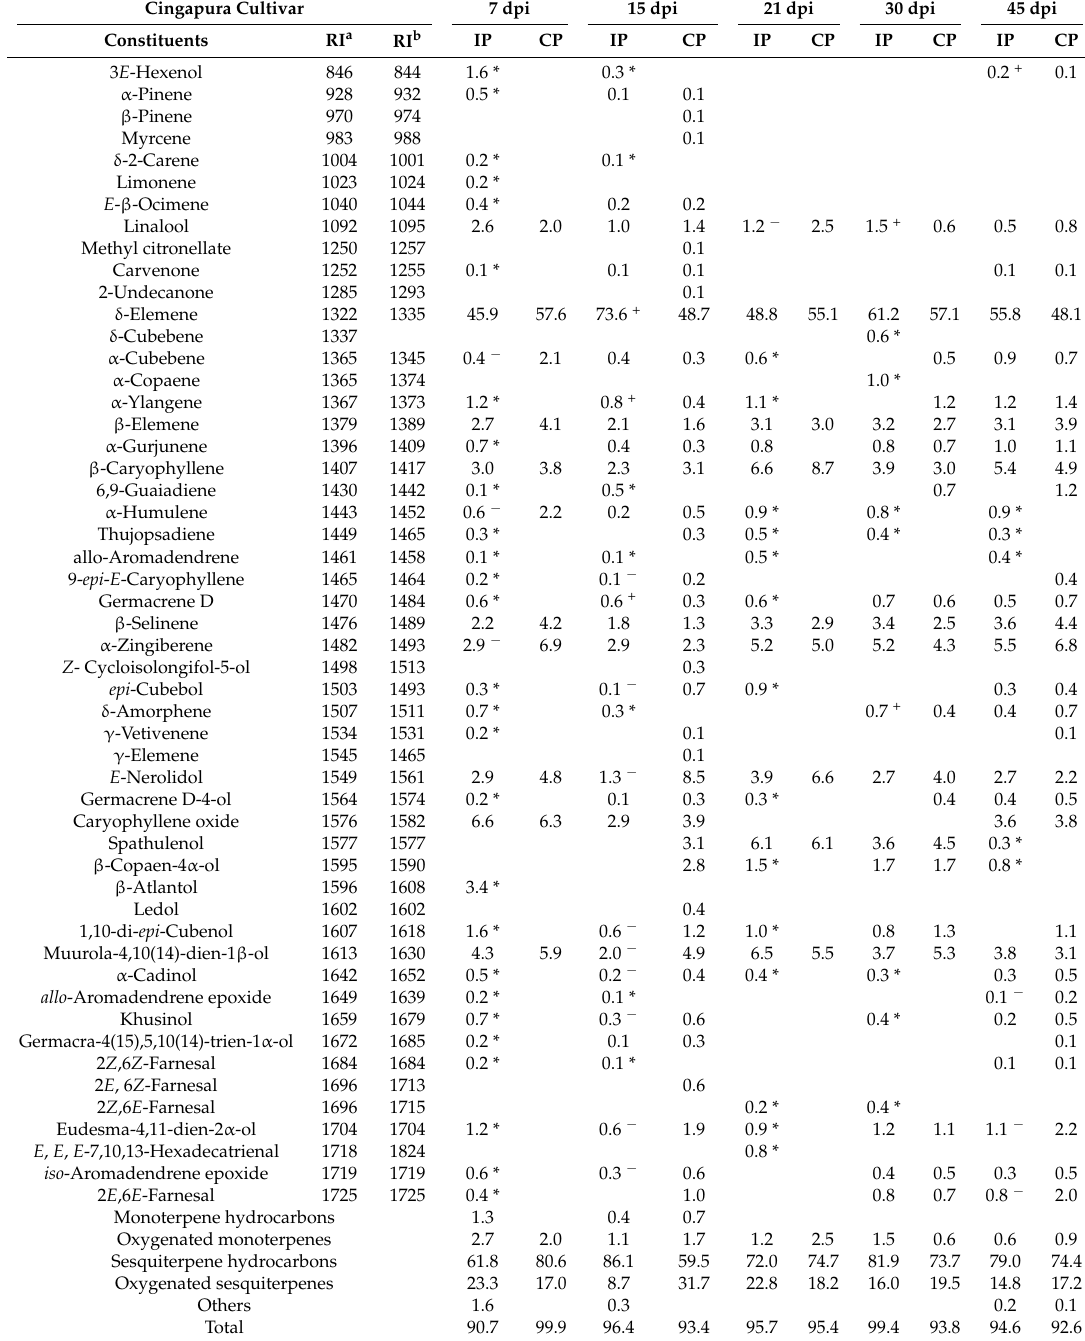
Table 2. Volatile compounds (%) of the leaves of Cingapura cultivar: inoculated plants (IP) and control plants